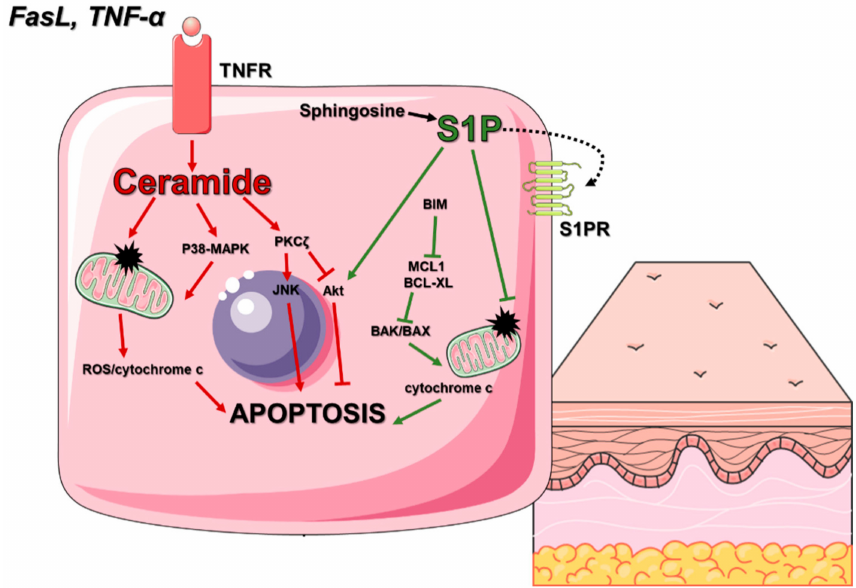
Figure 2. Role of the ceramide (Cer) and sphingosine-1-phosphate (S1P) in keratinocyte apoptosis and survival. Ceramide (activated by FasL or TNF- α ) acts as a secondary lipid transmitter leads to apoptosis through stimulation of specific protein targets, such as P38-MAPK, PKC ζ or JNK and inhibition of Akt kinase activity or through direct permeabilization of the mitochondrial membrane and release of cytochrome c into the cytoplasm. S1P acts as a ceramide antagonist, promoting cell survival by blocking a BIM-dependent signalling cascade, thus preventing the release of cytochrome c from mitochondria or by activating Akt. Akt —protein kinase B; BAK